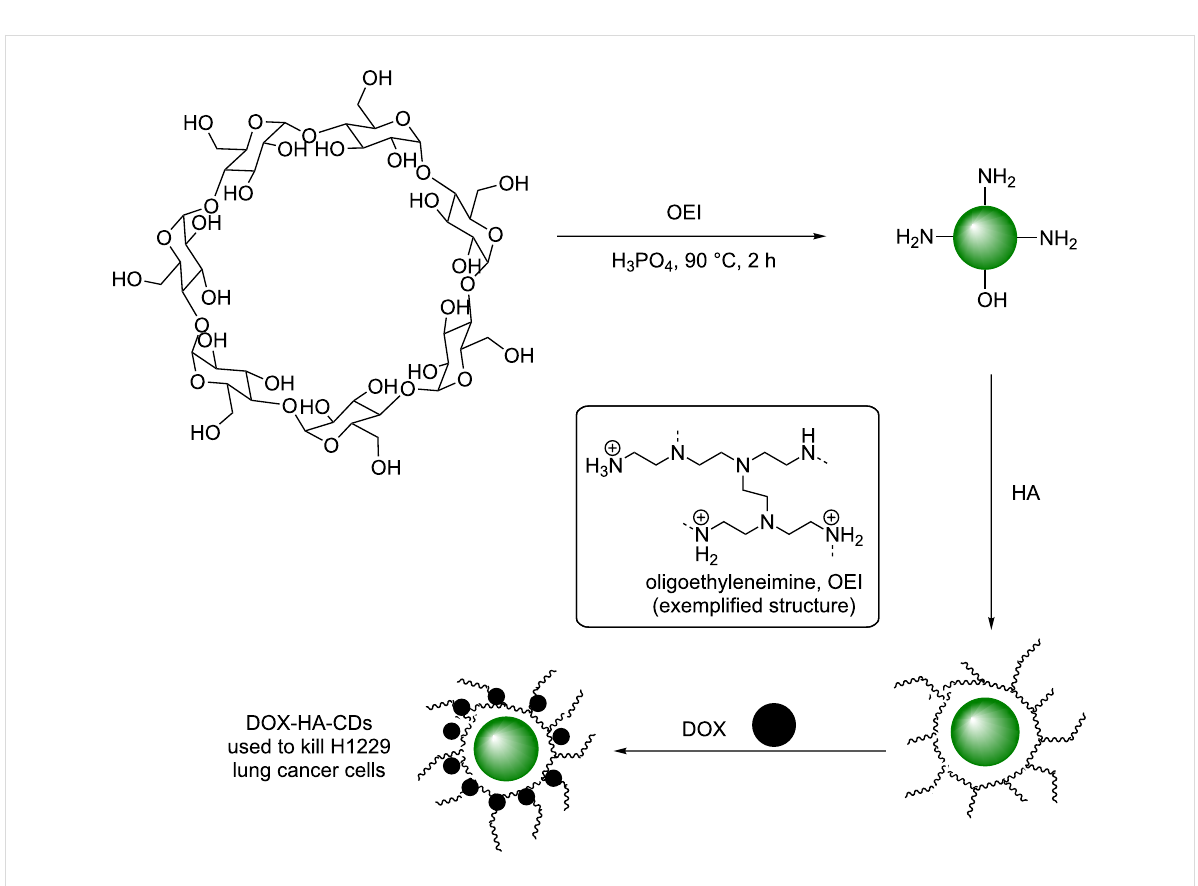
Scheme 24: Cyclodextrin and OEI-derived CDs, coated with hyaluronic acid and DOX, to produce an effective lung cancer cell drug-delivery